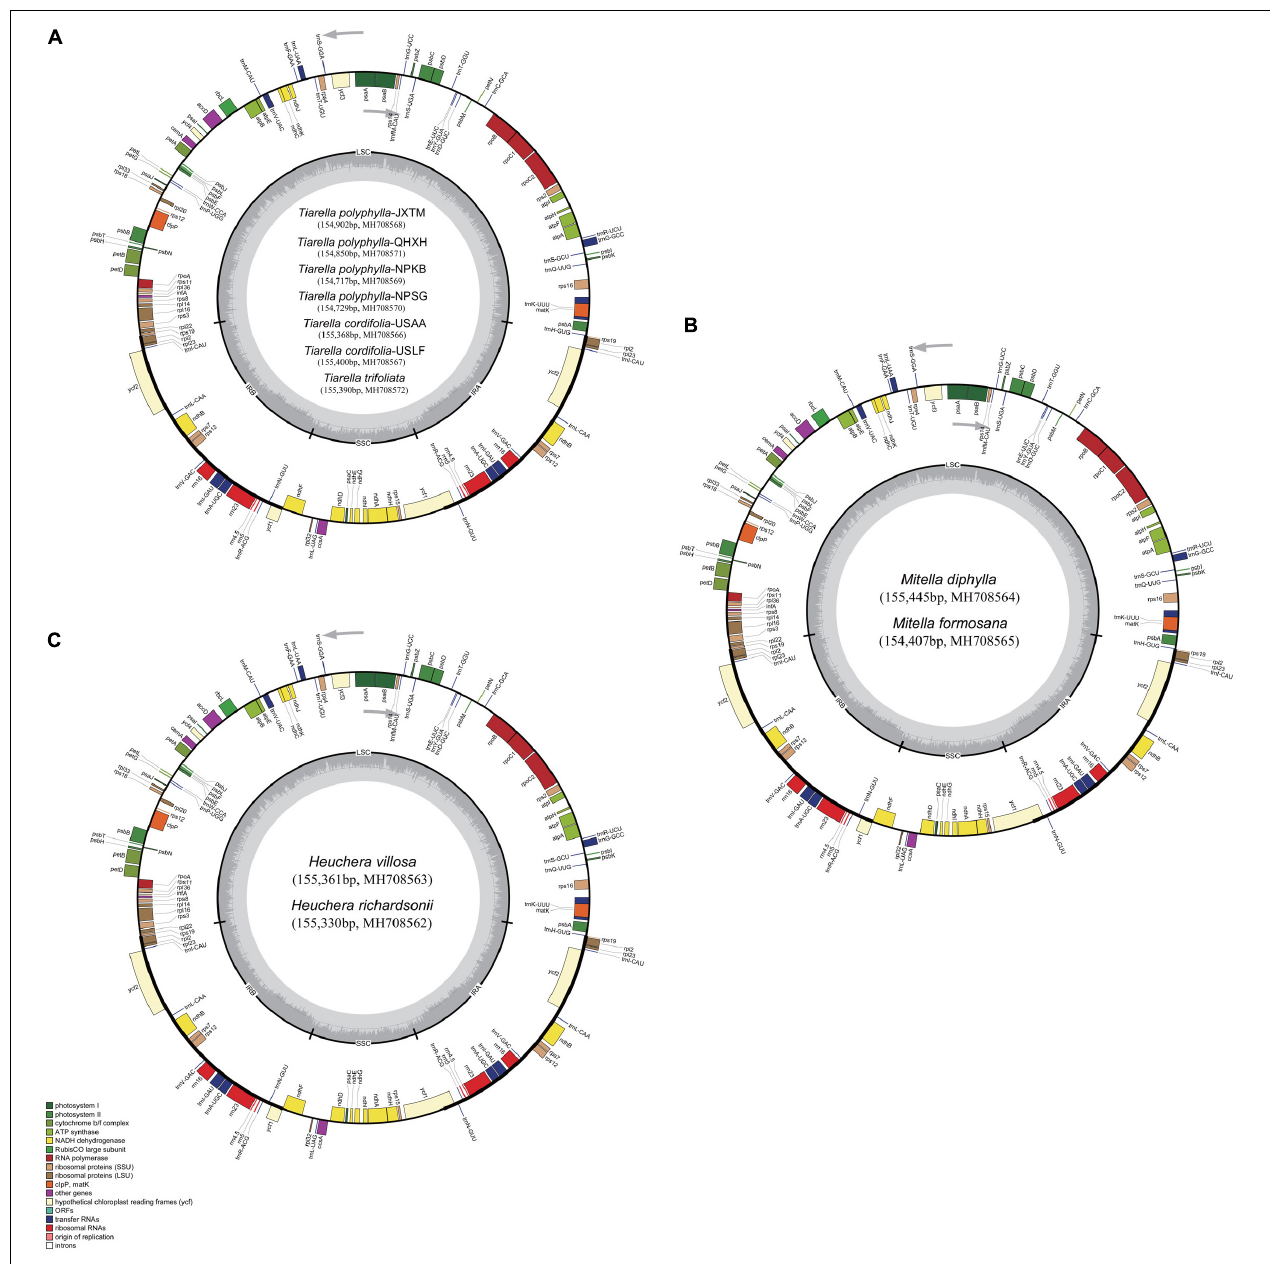
FIGURE 1 | Plastome maps of Tiarella, Heuchera , and Mitella . (A) Seven Tiarella plastomes including four T. polyphylla individuals, two T. cordifolia , and one T. trifoliata , (B) Two Mitella plastomes including M. diphylla and M. formosana (C) Two Heuchera plastomes including H. villosa and H. richardsonii . Genes inside the circle are transcribed clockwise, gene outside are transcribed counter-clockwise. The light gray inner circle corresponds to the AT content, the dark gray to the GC content. Genes belonging to different functional groups are shown in different colors; see the legend for groups.